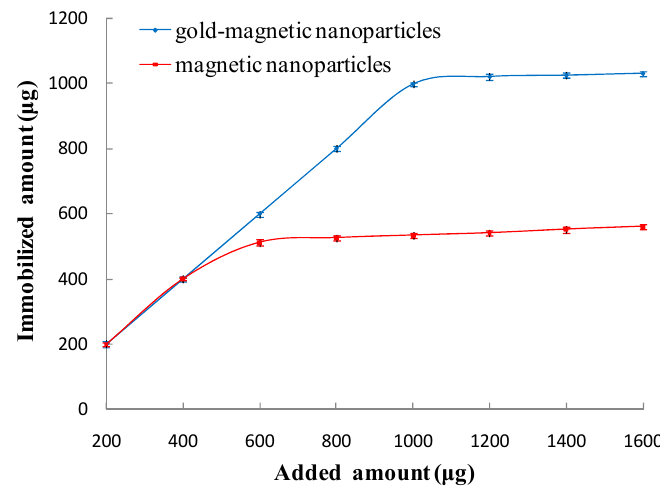
Figure 5. Immobilization ability of polyclonal antibody on 1 mg of gold-magnetic nanoparticles and magnetic nanoparticles.